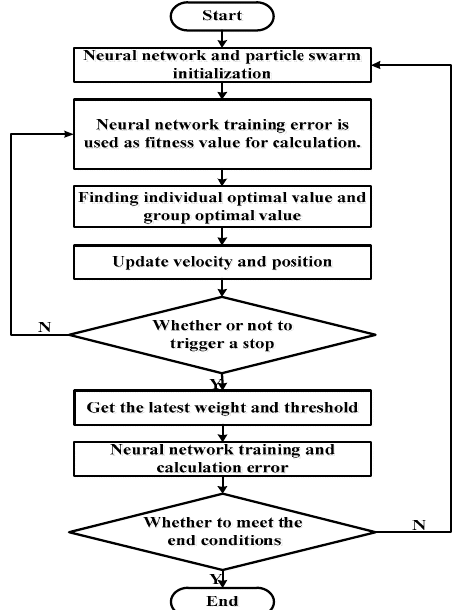
Figure 4. Back propagation (BP) neural network improvement algorithm.